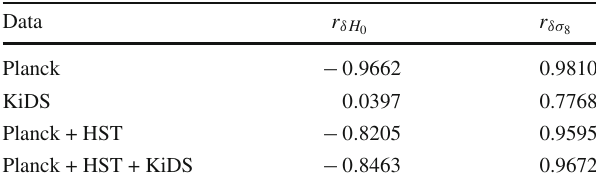
Fig. 3 δ − H 0 (left panel) and δ − σ 8 (right panel) parametric spaces (68% and 95% CL) for the IVCDM model from three data sets. The yellow band corresponds to local value H 0 = 73 . 24 ± 1 . 74 km s − 1 Mpc − 1 [4] whereas the light red band corresponds to σ 8 = 0 . 75 ± 0 . 03 [6] Table 2 Correlation r of δ with H 0 and σ 8